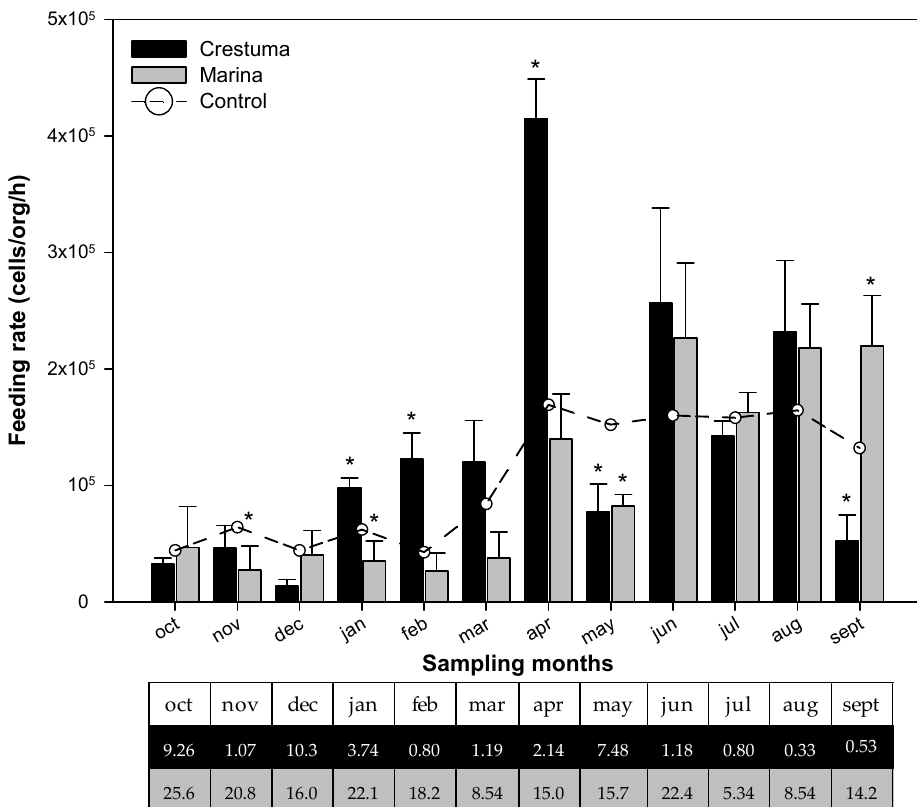
Figure 2. Results of D. magna feeding rate after exposures to water samples from Crestuma and Marina collected throughout the sampling period. Data are expressed as mean ± standard error; * stands for significant differences when compared to control in each sampling period (Dunnett test, p < 0.05). Table shows the results of chlorophyll a concentration recorded in each sampling site and sampling period. Table 3. Summary of one ‐ way analysis of variance (ANOVA) applied to D. magna feeding rate results. Bold values stand for significant differences between treatments.